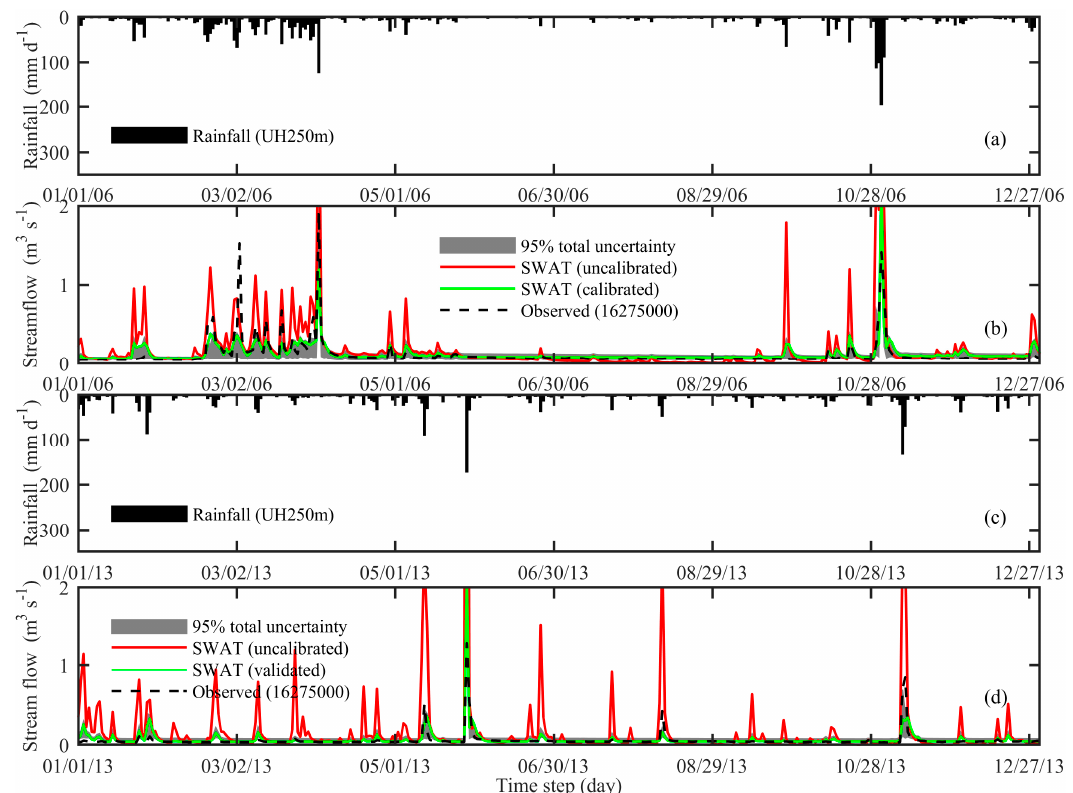
Figure 5. ( a ) Daily UH250m rainfall of 2006 and ( b ) the respective observed and simulated daily streamflows at USGS gauging #16275000 (calibration period); and ( c ) daily UH250m rainfall of 2013 and ( d ) the respective simulated and observed daily streamflows (validation period) at Haiku.